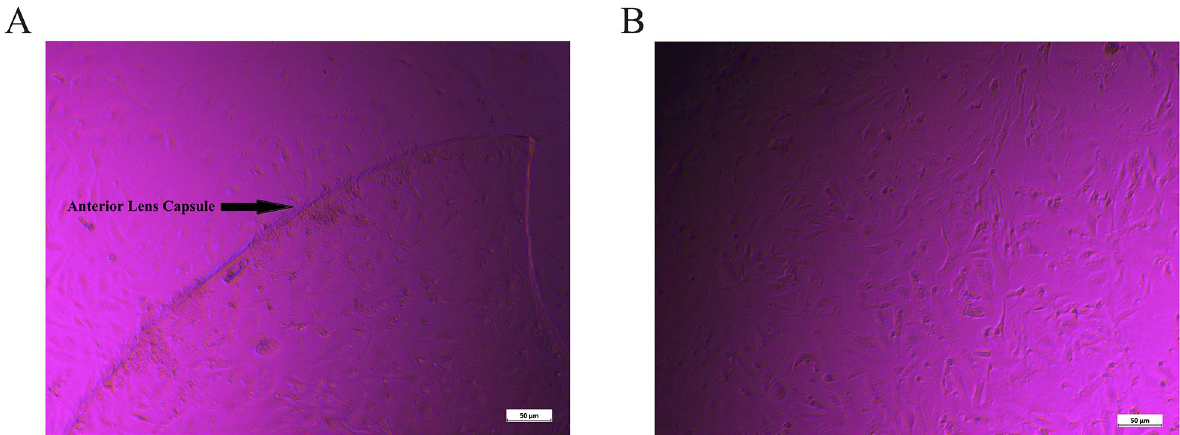
Fig. 2 A Section from anterior lens capsule specimen. B Passaged lens epithelial cells. Cultures were examined by inverted light microscopy (Leica, Germany). Scale bar 50 μm =